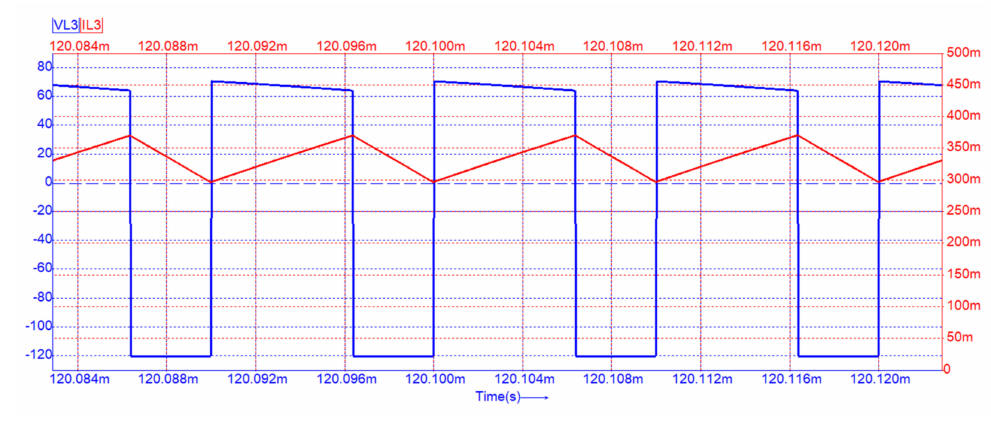
Figure 12. Voltage (blue) and current (red) for the inductor L 3 .